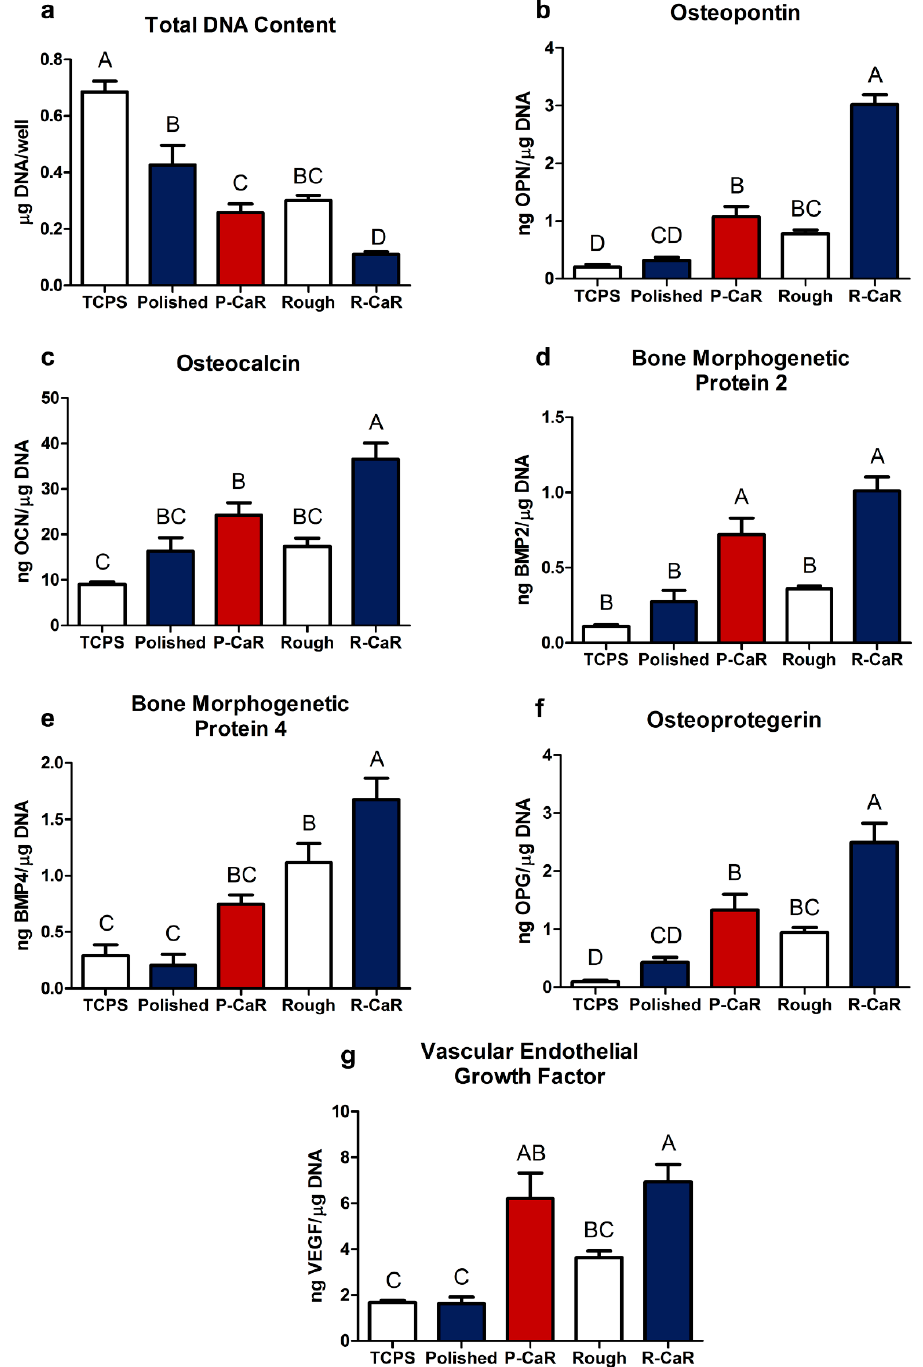
Figure 7. Responses of MSCs to reaction-modified TiAl6V4 surfaces: ( a ) total DNA content, ( b ) os- teopontin content, ( c ) osteocalcin content, ( d ) BMP 2 content, ( e ) BMP 4 content, ( f ) OPG content; ( g )